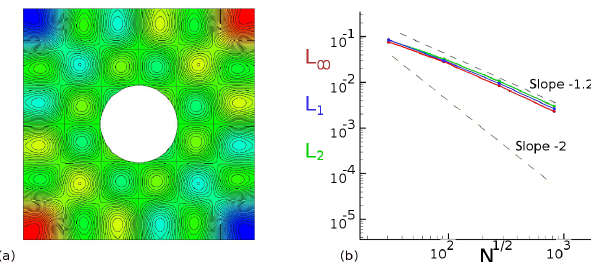
Figure A1. Array of vortices around a cylinder: (a) illustration; (b) L ∞ , L 1 and L 2 norm functions of the space resolution.